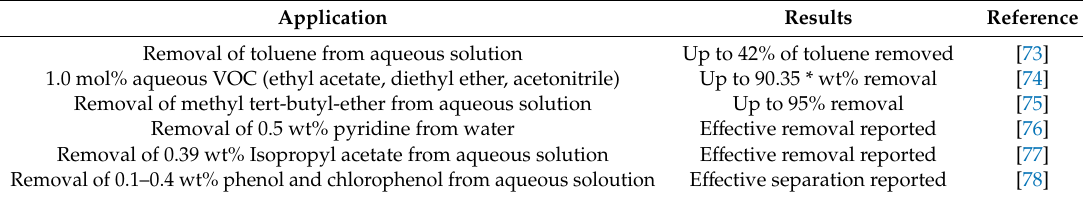
Table 5. Applications of pervaporation in the removal of specific